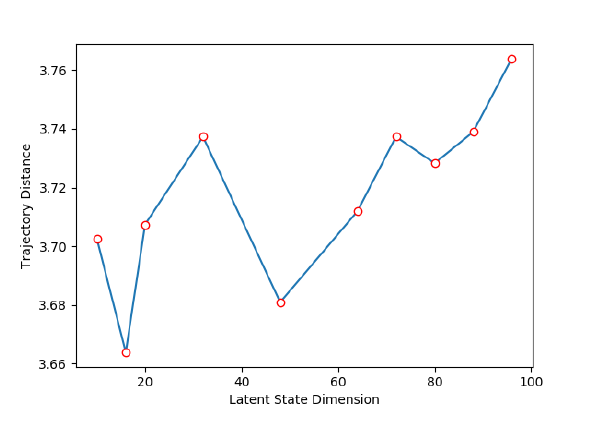
Figure 6. Trajectory distance with different parameter λ .